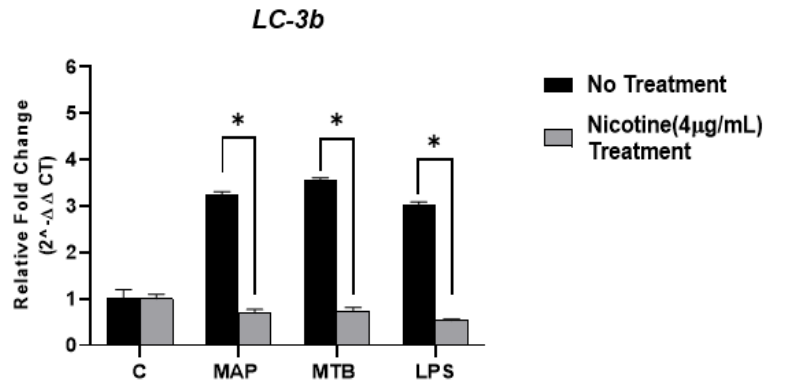
Figure 3. Effect of nicotine on the LC-3b expression in infected macrophages. THP-1 PMA differen- tiated macrophages were infected with MAP and MTB, or treated with LPS for 24 h, then treated with nicotine (4 µ g/mL). Expression of LC-3b was measured by RT-PCR. All experiments were performed in duplicate. MAP: Mycobacterium avium paratuberculosis . MTB: Mycobacteria tubercalusis . LPS: lipopolysaccharide derived from Escherichia coli ATCC 8739. * p < 0.05.